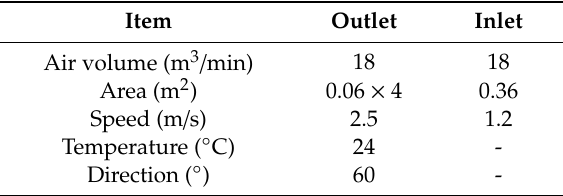
Table 2. Boundary conditions of the air conditioner.